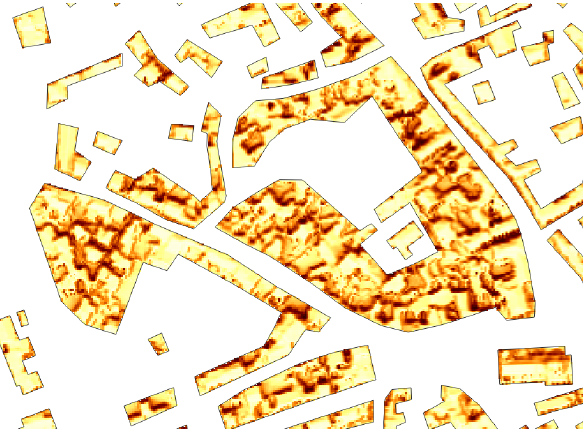
Figure 14. Portion of the irradiation map in which the perimeter of some buildings does not follow the actual perimeter of the buildings themselves, but also erroneously includes the inner courtyards, thus misleading the algorithm that considers vegetation, for example, as an irregular cover. Surfaces with a slope exceeding 45 ◦ and not belonging to contiguous areas of at least 30 m 2 are, in any case, not considered in the calculation of municipal and regional photovoltaic